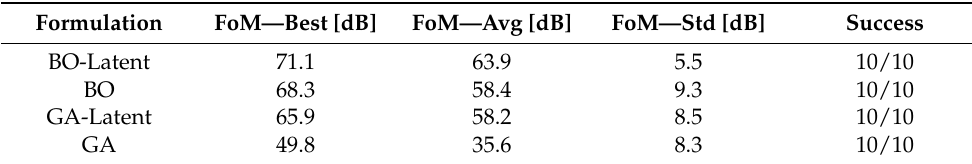
Table 4. Wideband LNA sizing